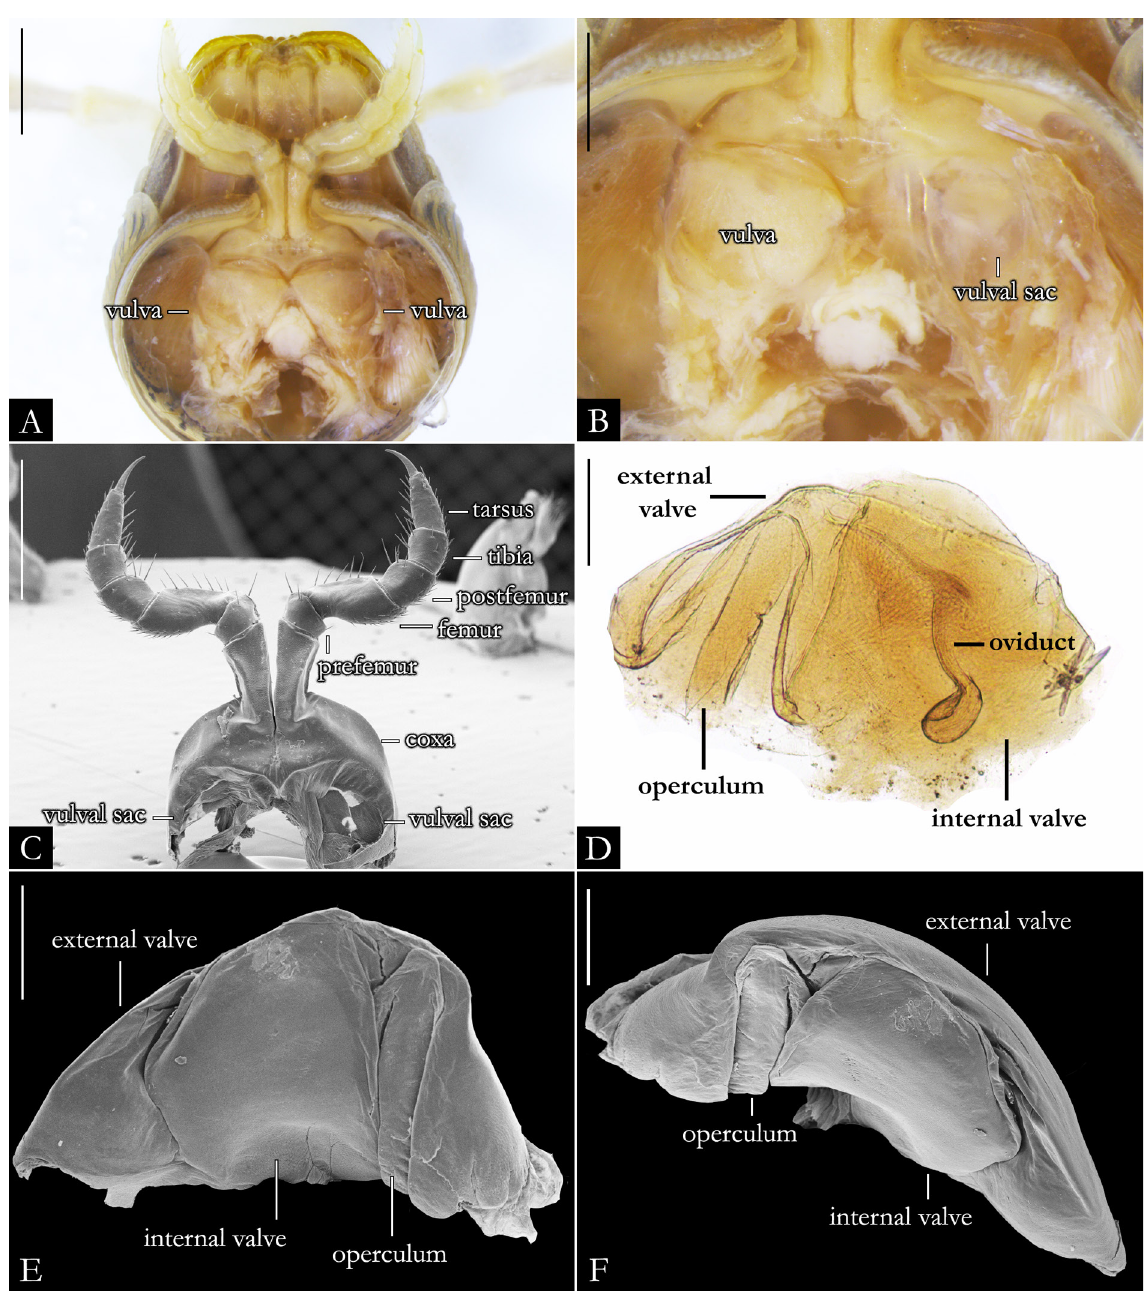
Fig. 39. SEM and stereoscopic images of sexual structures of females. A . Anterior rings in anal view, Pseudonannolene microzoporus Mauriès, 1987 (IBSP 3497). B . Detail of second leg-pair of P. microzoporus (IBSP 3497). C . Second leg-pair of P. robsoni Iniesta & Ferreira, 2014 (IBSP 3504). D . Left vulva of P. microzoporus (IBSP 3497). E–F . Right vulva of P. robsoni (IBSP 3504). Scale bars: A, C = 1 mm; B, D = 0.5 mm; E = 0.25 mm; F = 0.2